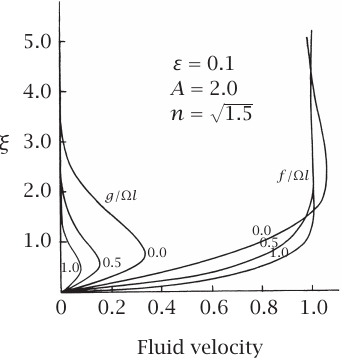
Figure 3.2 . Variations of f/ Ω l and g/ Ω l for different values of suction pa- rameter S in presence of variable suction A .